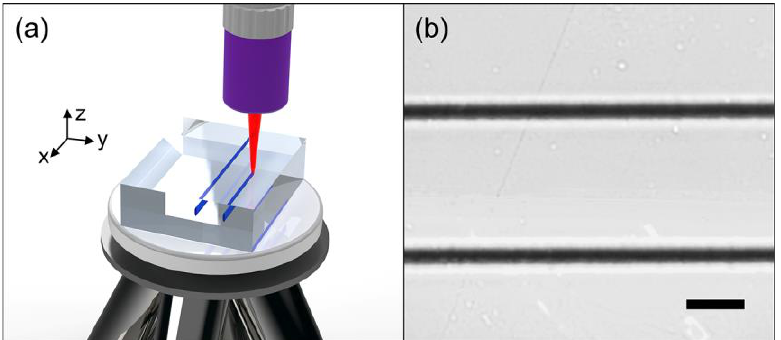
Figure 1. ( a ) The schematic diagram of femtosecond laser processing. Coordinate axes are defined here. ( b ) The microscope image of the processed KTN sample (x × y facet). The scale bar in ( b ) is 20 µ